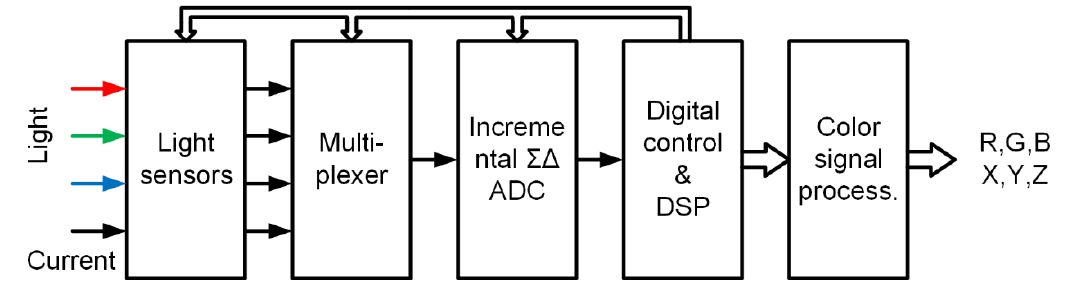
Figure 1. Color measurement